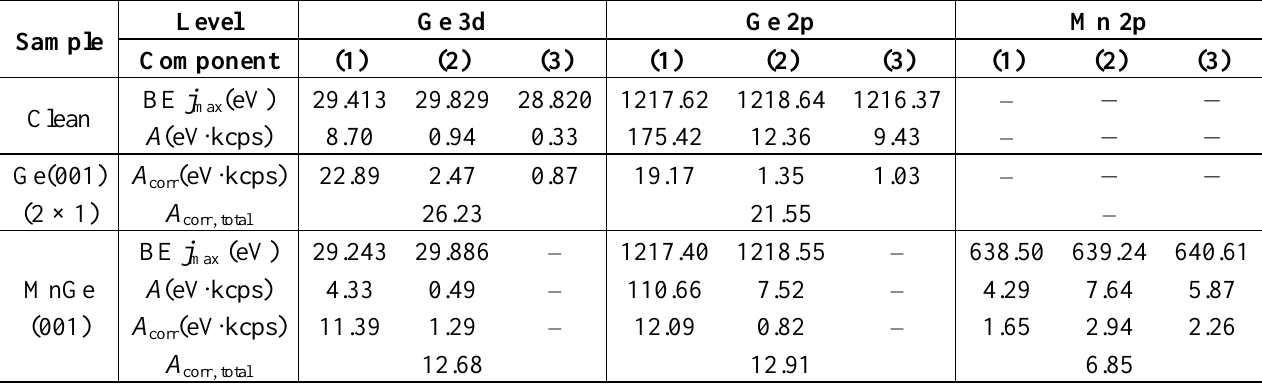
Table 1. Relevant parameters obtained from the X-ray photoelectron spectroscopy (XPS) data analysis represented in Figure 5: energies and integral amplitudes for each separate component used in the fit. The corrected amplitudes ( A ) are obtained by dividing the corr integral amplitudes ( A ) by the Wagner atomic sensitivity factors [60]. The binding energies (BE) represented are that of the maximum angular moment line from each doublet: j = 3/2 for 2p states and 5/2 for 3d states. Experimental errors are of the order of ± the max least significant digit of each binding energy or integral